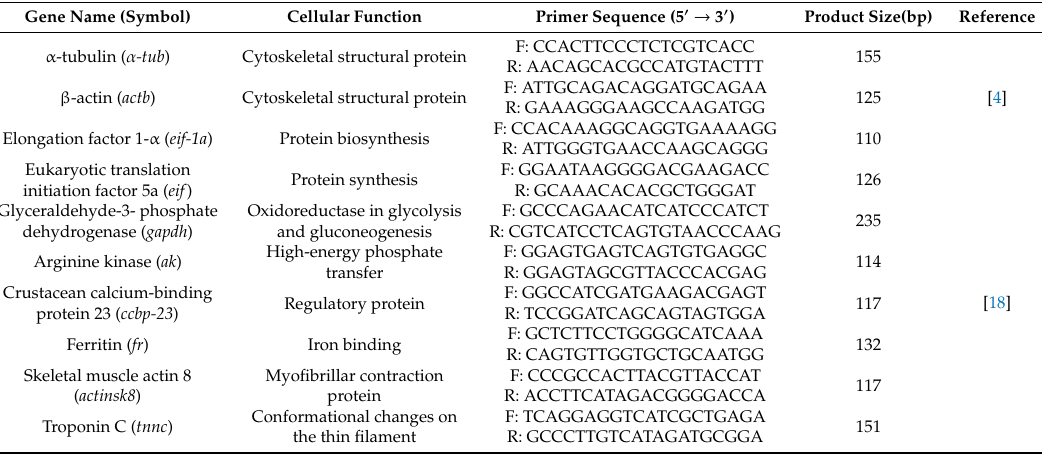
Table 1. List of genes analysed in the study including primer